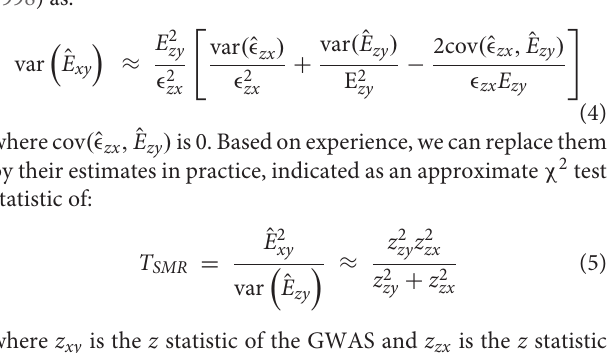
Frontiers in Genetics |